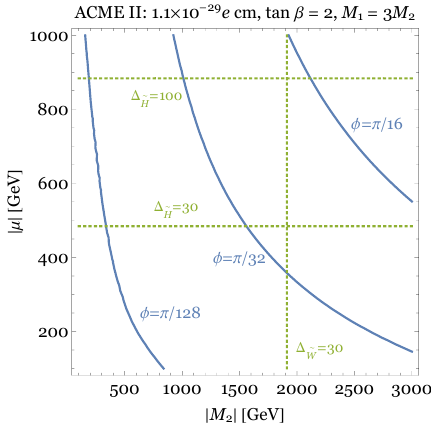
Figure 6 . Constraints on electroweakinos from EDMs: the case of small phases. Here we have (cid:12)xed M 1 = 3 M 2 , as in anomaly mediated SUSY breaking, and tan (cid:12) = 2. We see that the ACME result is compatible with light electroweakinos only for percent-level